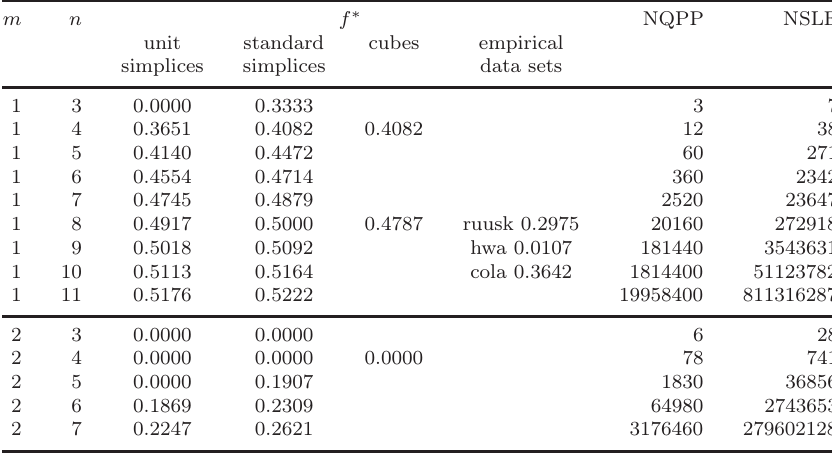
Table 1. Results of explicit